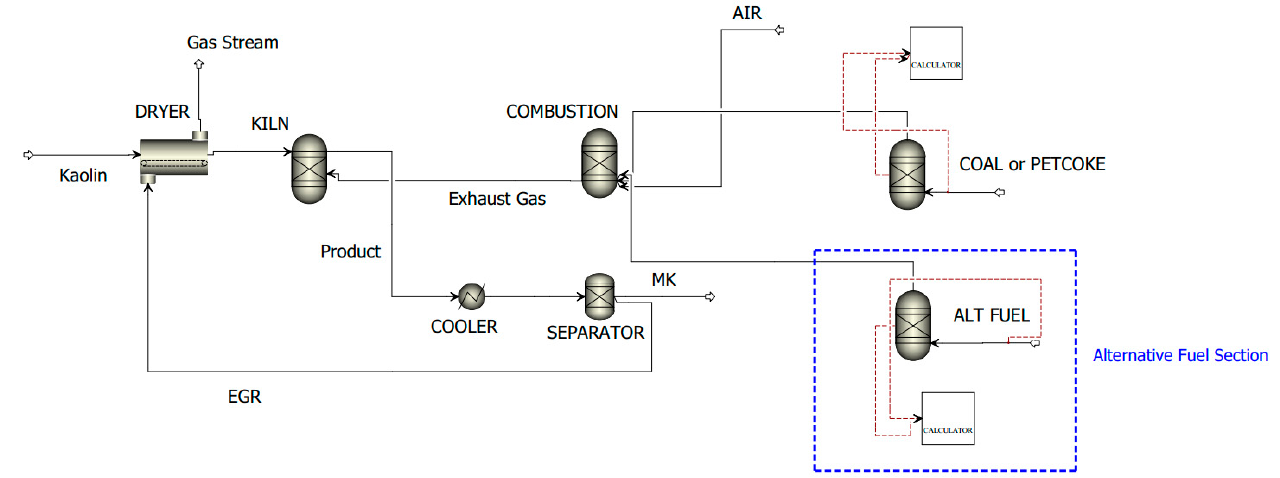
Figure 2. Process-model flowsheet for MK production (MK-SF configuration).